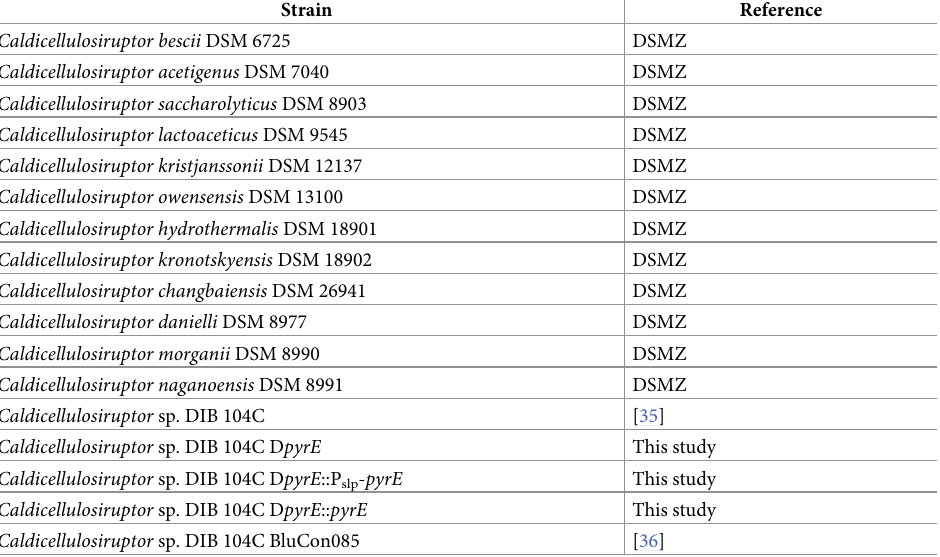
Table 1. List of strains used and constructed in this